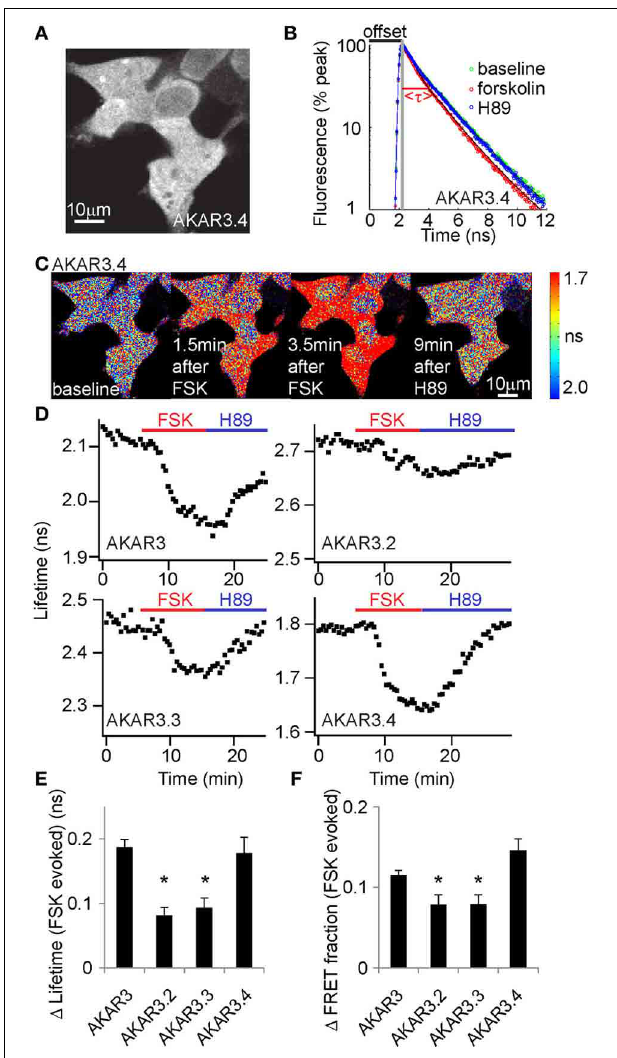
FIGURE 2 | AKAR3.4 reports PKA activity with the largest dynamic range in 2pFLIM measurements. (A) Image showing AKAR3.4 expression in Human Embryonic Kidney (HEK) cells 1 day after transfection. (B) Fluorescence decay curves following pulsed excitation. Application of the adenylate cyclase activator forskolin (50 μ M) in AKAR3.4-transfected HEK cells results in faster decay and a decrease in lifetime, whereas application of the PKA inhibitor H89 (10 μ M) reverses the decay curve to baseline. The offset arrival time, the time from the detection of photon excitation from the laser to the detection of the same pulse from the photomultiplier tube, is labeled in black, and the actual mean fluorescent lifetime τ is labeled in red. (C) Lifetime heat map of HEK cells transfected with AKAR3.4, showing lifetime changes induced by forskolin (FSK, 50 μ M) followed by H89 (10 μ M) treatment. (D) Example plots showing lifetime responses of the four different reporters to forskolin (50 μ M, red bar) followed by H89 (10 μ M, blue bar) treatment. Experiments were done in HEK cells transfected with the respective reporters. (E) Amplitudes of (cid:2) lifetime between baseline and forskolin (50 μ M) treatments. (F) Change in the FRET fraction of photons (P FRET based on the annotation in Supplementary Figure 1 ) between baseline and forskolin (50 μ M) treatments. For (E,F) , n = 12, 10, 14, and 12 cells for AKAR, AKAR3.2, AKAR3.3, and AKAR3.4 respectively. ∗ p < 0 . 003 when the amplitudes of the reporter and AKAR3.4 were compared ( α = 0 . 017 for a familywise error rate of